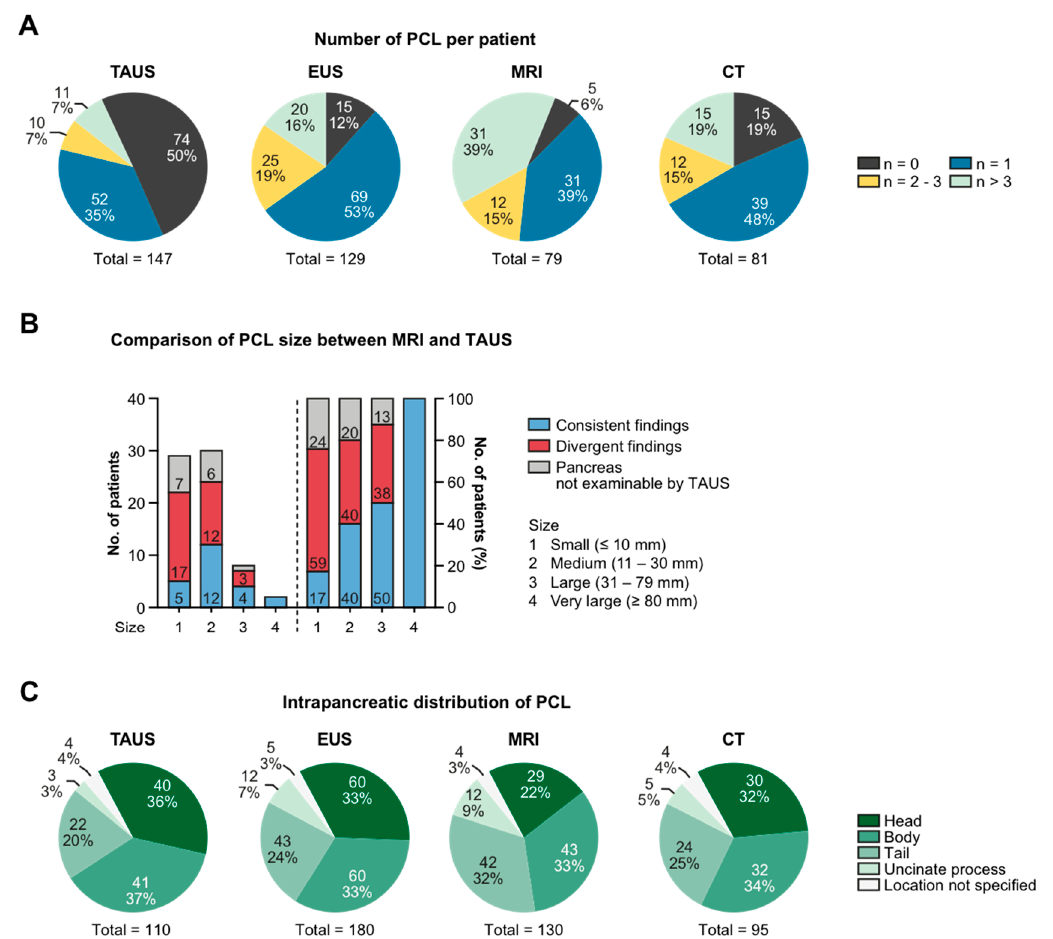
Figure 5. ( A ) Quantification of cysts per patient and imaging modality. ( B ) Comparison of PCL size determined by MRI with TAUS measurements; ( C ) Intrapancreatic localization of PCLs arranged by anatomical segment. Pancreatic cystic lesion, PCL; transabdominal ultrasound, TAUS; endoscopic ultrasound, EUS; magnetic resonance imaging, MRI; computed tomography, CT.